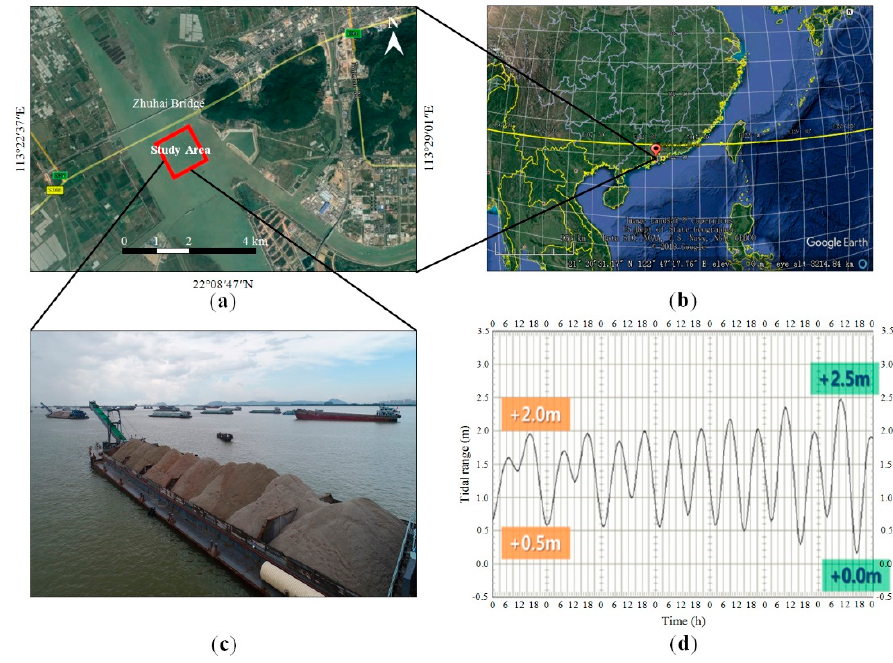
Figure 1. Test site downstream of the Zhuhai Bridge, Southern China: ( a ) the study area that includes several barges; ( b ) the geospatial location described by Google Earth; ( c ) on-site several barges; ( d ) a tidal change plot in the test site.